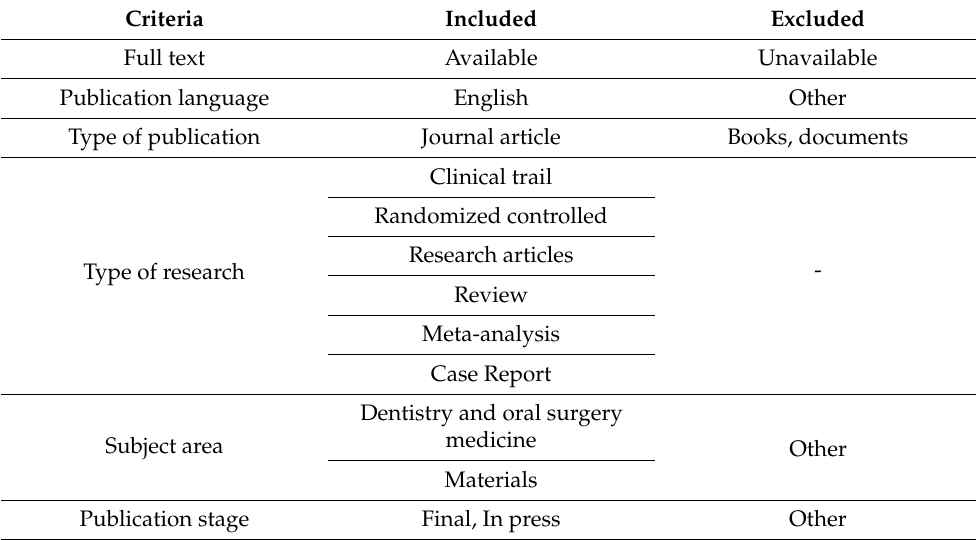
Table 3. Exclusion and inclusion